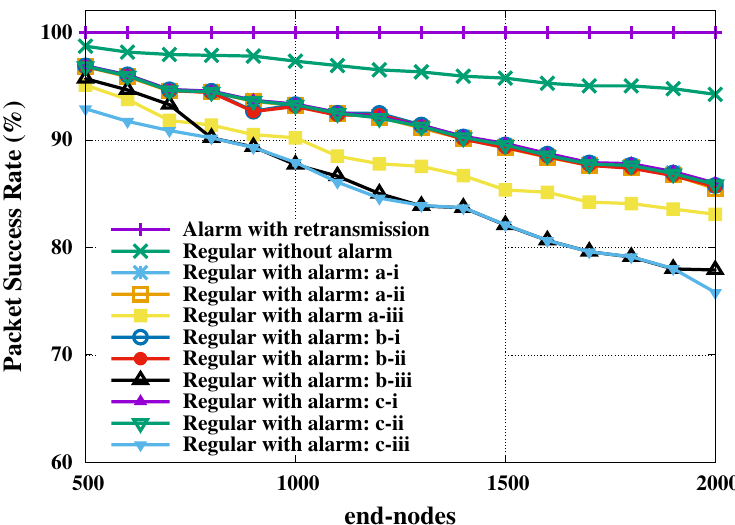
Figure 5. Regular and alarm nodes’ packet success rate for open field and one gateway. Regarding a 95% confidence level, the largest margins of error, in percentage points, are: 0.034 (alarm